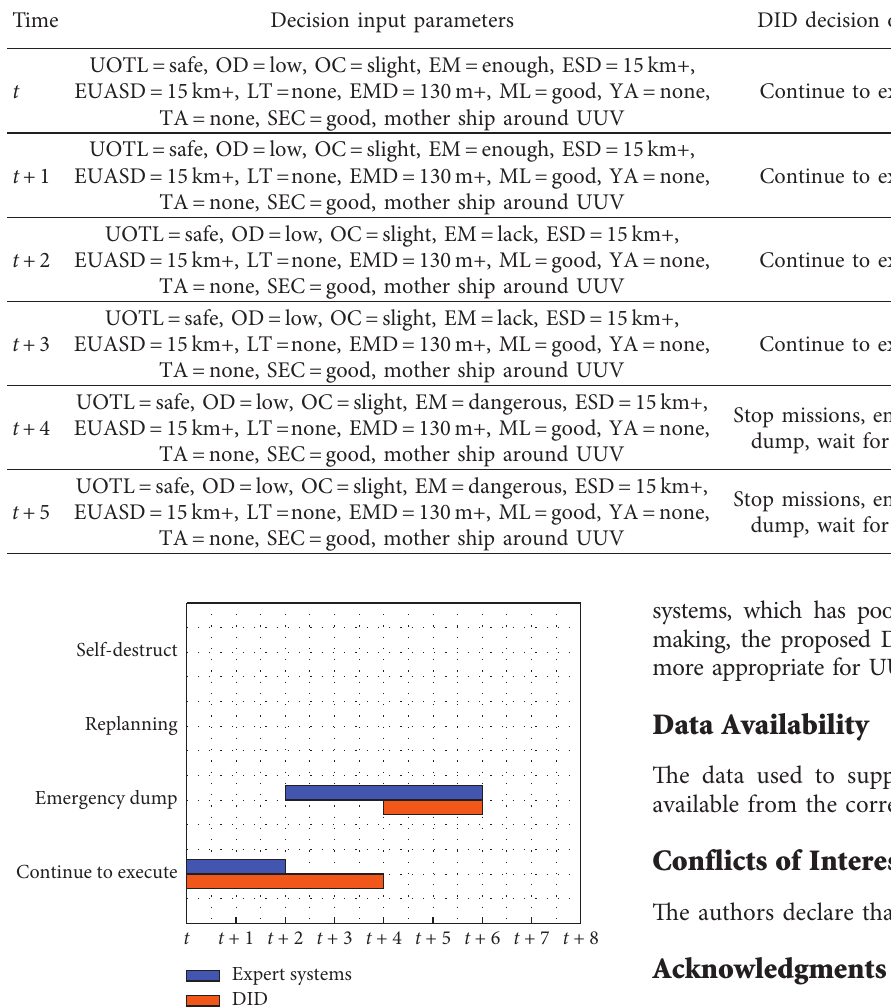
Figure 9: Decision progress for the DID and expert